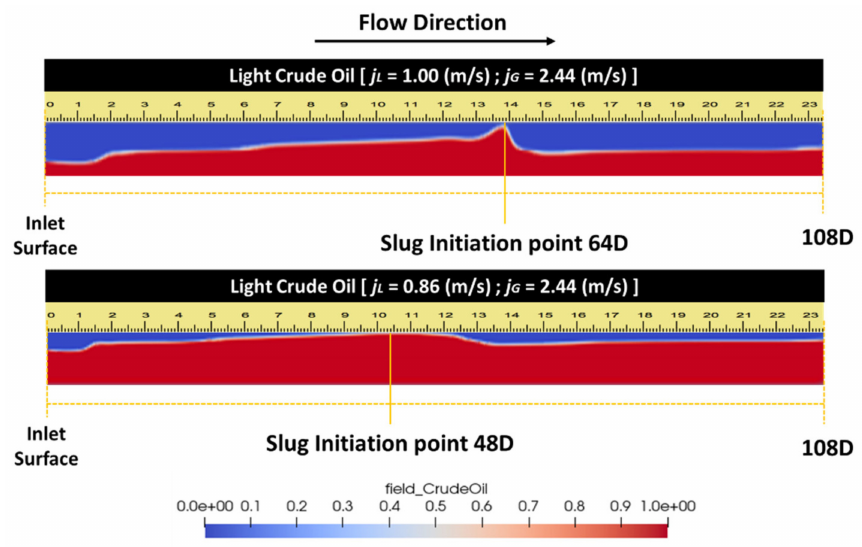
Figure 11. Effect of varying liquid superficial velocities on slug initiation position (‘D’ represents pipe diameter).